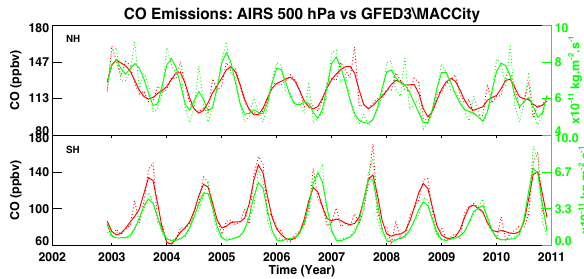
Figure 8b. The CO emission inventories (kg.m -2 .s -1 ) from the MACCity natural sources (red) and GFED3 anthropogenic sources (blue) for the NH (upper panel) and the SH (lower panel).